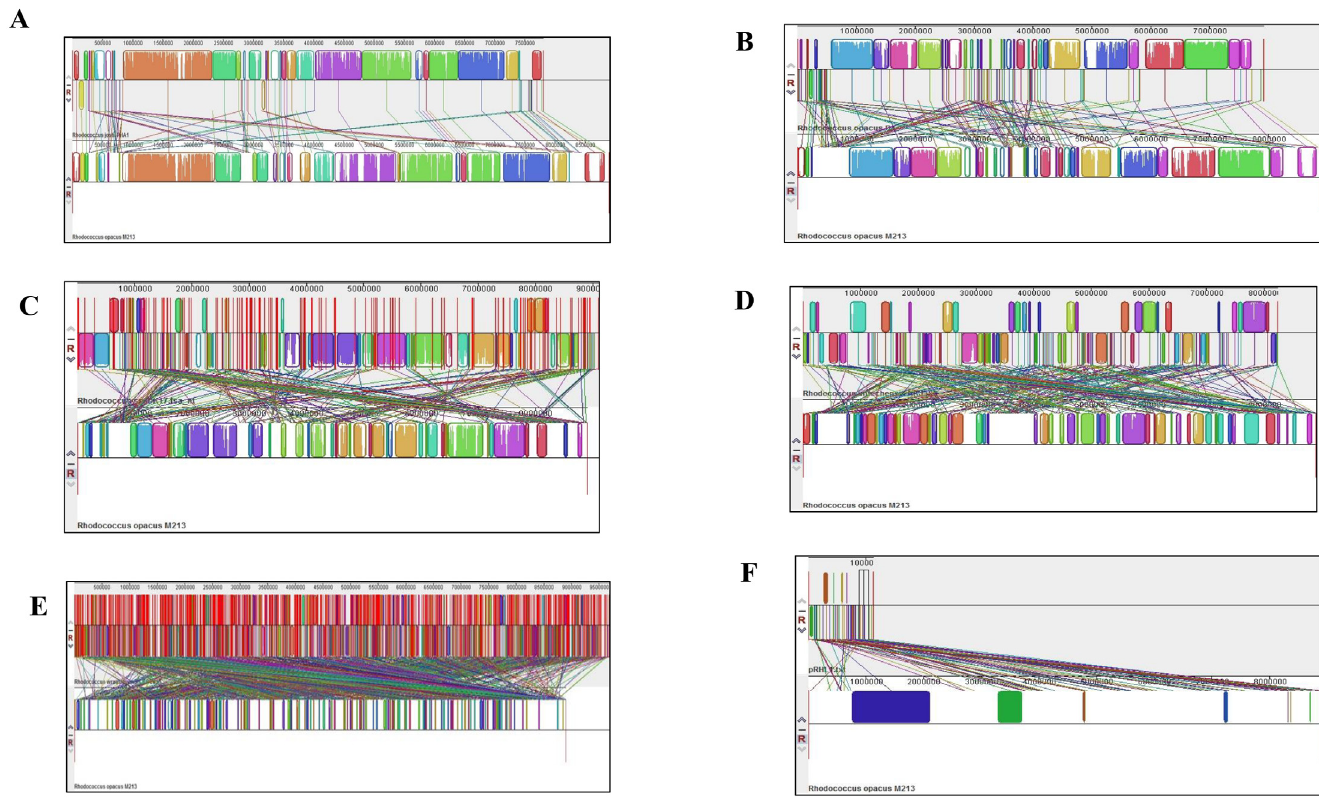
Fig 6. Whole genome comparative alignment of R . opacus strain M213 with Rhodococcus jostii strain RHA1. (A); Rhodococcus opacus strain B4 (B); Rhodococcus strain DK17 (C); Rhodococcus imtechensis RKJ300 (D); and Rhodococcus wratislaviensis strain IFP2016 (E), respectively. Also shown is the whole genome comparative analysis of R . opacus strain M213 with plasmid pRHL1 from Rhodococcus jostii strain RHA1 (F). Each of the genome sequence analyzed is presented horizontally with the scale showing the sequence coordinates and the conserved segments represented as the colored blocks which are connected across genomes. Blocks that are shifted downward in a genome represent those segments that are inverted relative to the reference genomes. The aligned region is in the forward orientation relative to the first genome sequence if a block lies above the center line; blocks below the center line indicate regions that align in the reverse complement (inverse) orientation of the reference genome. Genomic regions falling outside the blocks lack a detectable homology among the genomes analyzed. Within each block is shown the similarity profile of the genome sequence such that the height of the similarity profile corresponds to the level of conservation in that specific region of the genome. White areas represent those genomic regions that did not align well between the input genomes and likely contain sequence elements specific to a particular